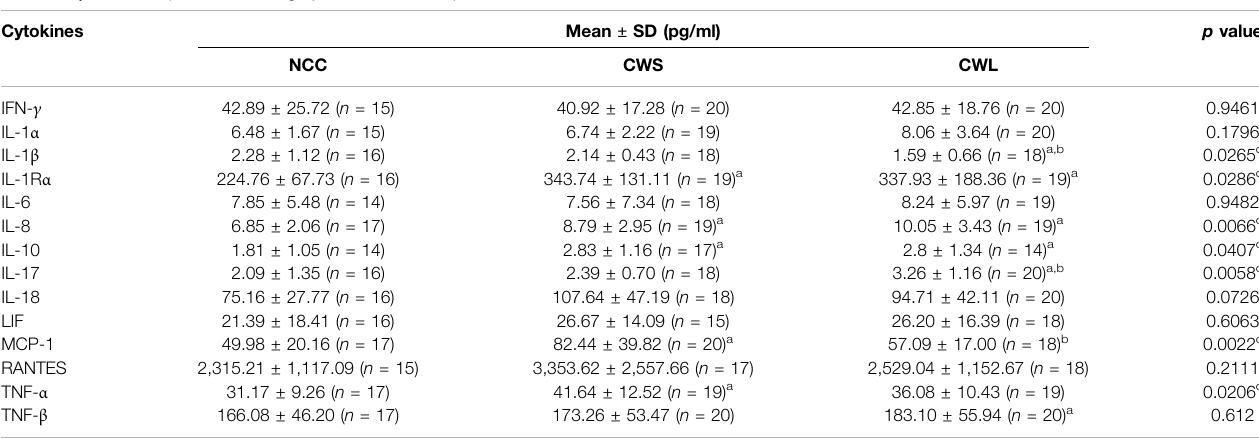
TABLE 2 | Levels of speci fi c circulating cytokines in cancer